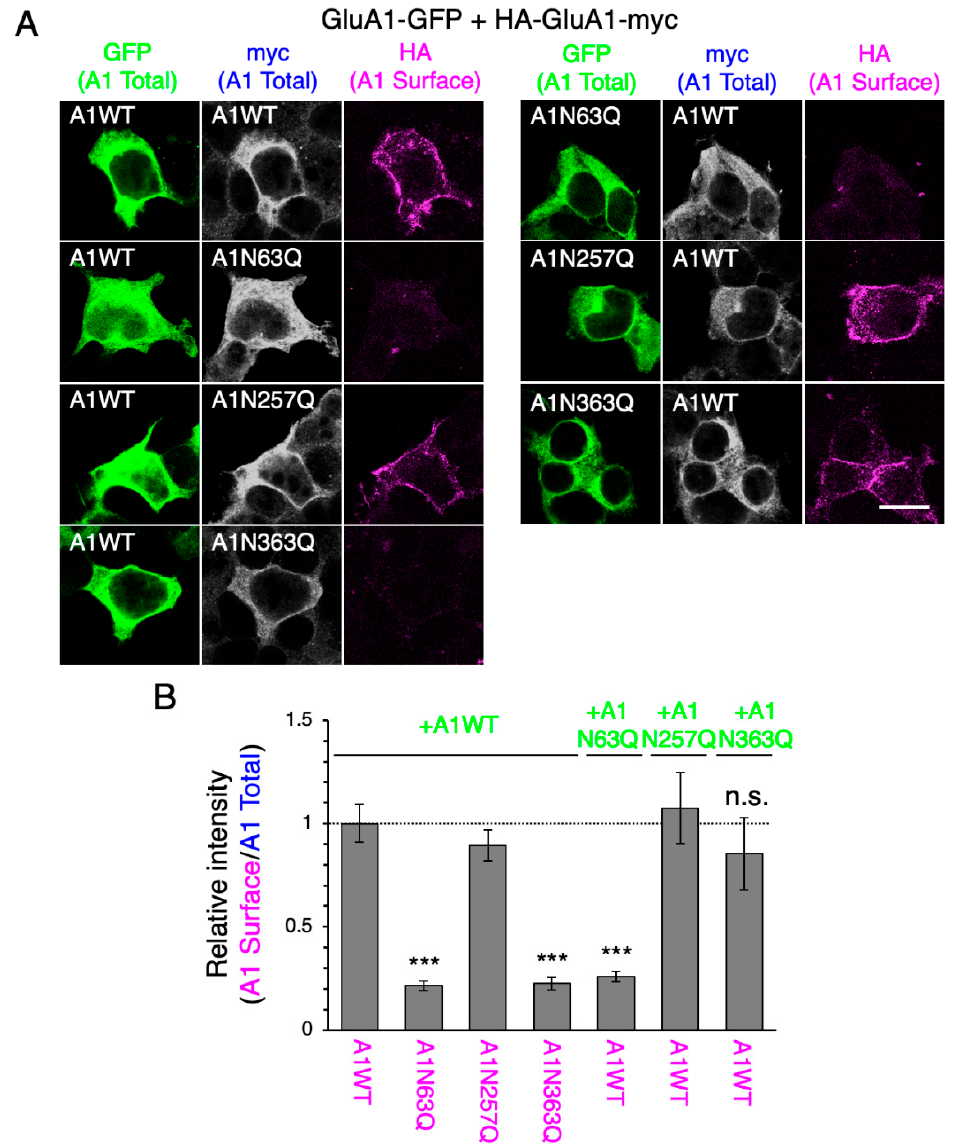
Figure 3. GluA1N63Q reduces the cell surface expression levels of GluA1WT. ( A ) Representative immunostaining images showing the cell surface levels of WT and mutant (N63Q, N257Q, and N363Q) GluA1 tagged with HA and myc (at the N- and C-terminus, respectively) in HEK293 cells co-expressing GFP-tagged WT or mutant GluA1 (green). Images were taken at 24 h post-transfection. Surface GluA1 was labeled using an anti-HA mAb (magenta; pseudocolor), and total GluA1 was detected using an anti-myc pAb (white; pseudocolor). Scale bar, 20 µ m. ( B ) Relative cell surface levels of HA-GluA1-myc WT and mutants in cells co-expressing WT and mutant GluA1-GFP. The fluorescence intensity of HA was normalized to that of myc and homo-oligomeric combination of WTs at 24 h post-transfection. Low GluA1N63 cell surface expression levels were observed, possibly due to anti-HA mAb internalization before cell fixation. ***, p < 0.001; n.s., p > 0.05. Error bars represent the SEM.